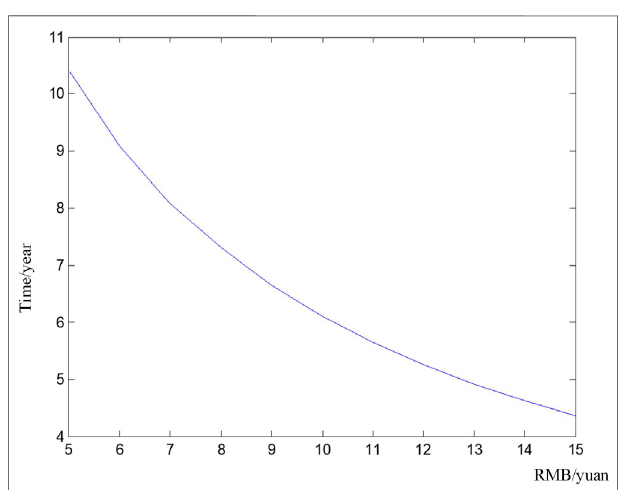
FIGURE 11 | Dynamic payback period for BESS in the face of changes in national electricity production.